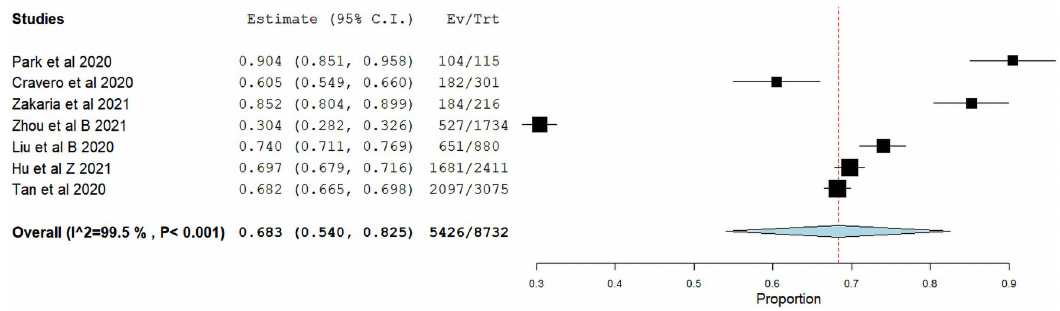
Fig 5. Forest plot of overall pooled prevalence of burnout.